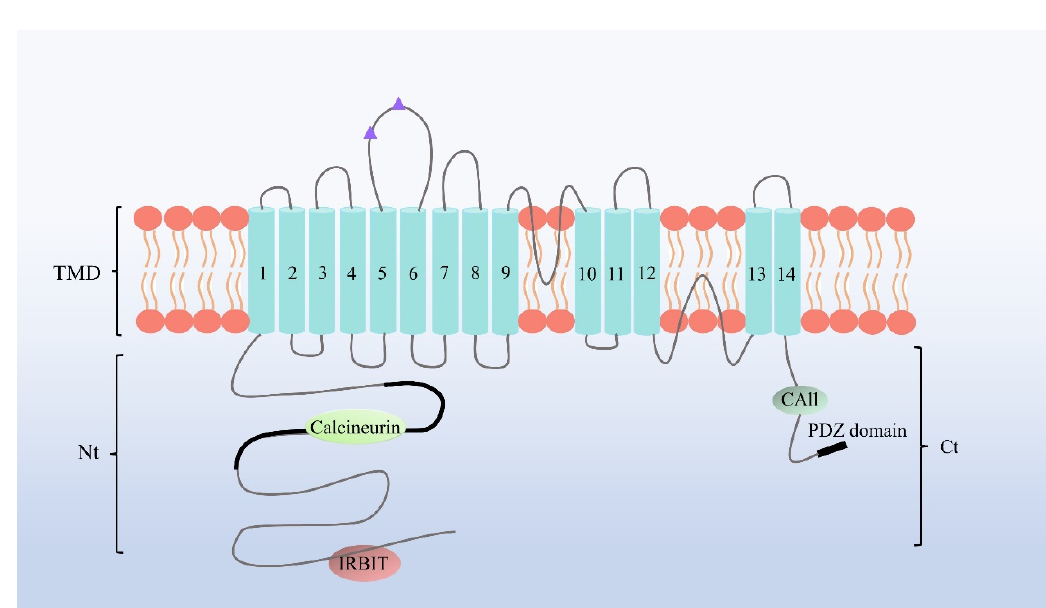
Figure 2. NBCn1 topology. The figure illustrates the predicted NBCn1 membrane topology and localization of the primary binding site, where IP3Rs binding protein released with IP3 (IRBIT) and Carbonic Anhydrase II (CAII) can enhance the activity of NBCn1.